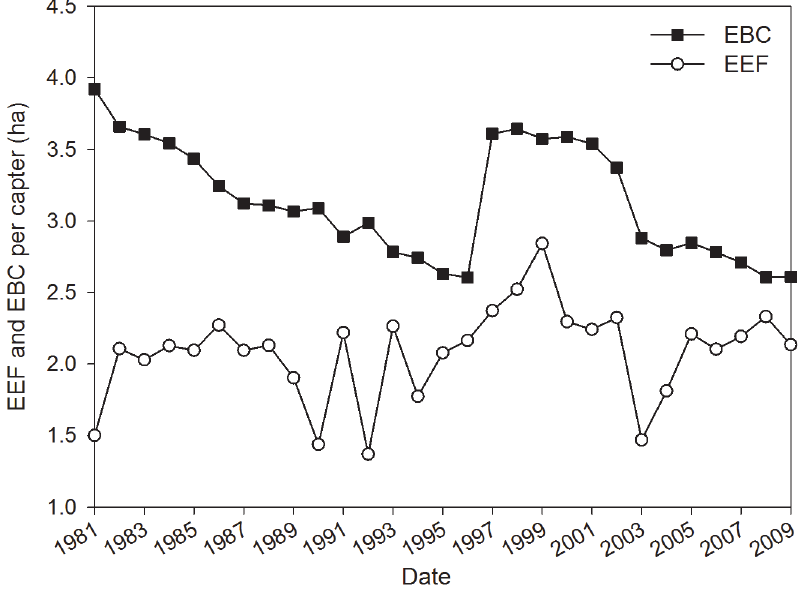
Fig 3. The emergetic ecological footprint (EEF) and emergetic biocapacity (EBC) per capita of cropland in Yuanzhou County, Ningxia Hui Autonomous Region, China during the period 1981 – 2009 as determined by Zhao ’ s calculation.